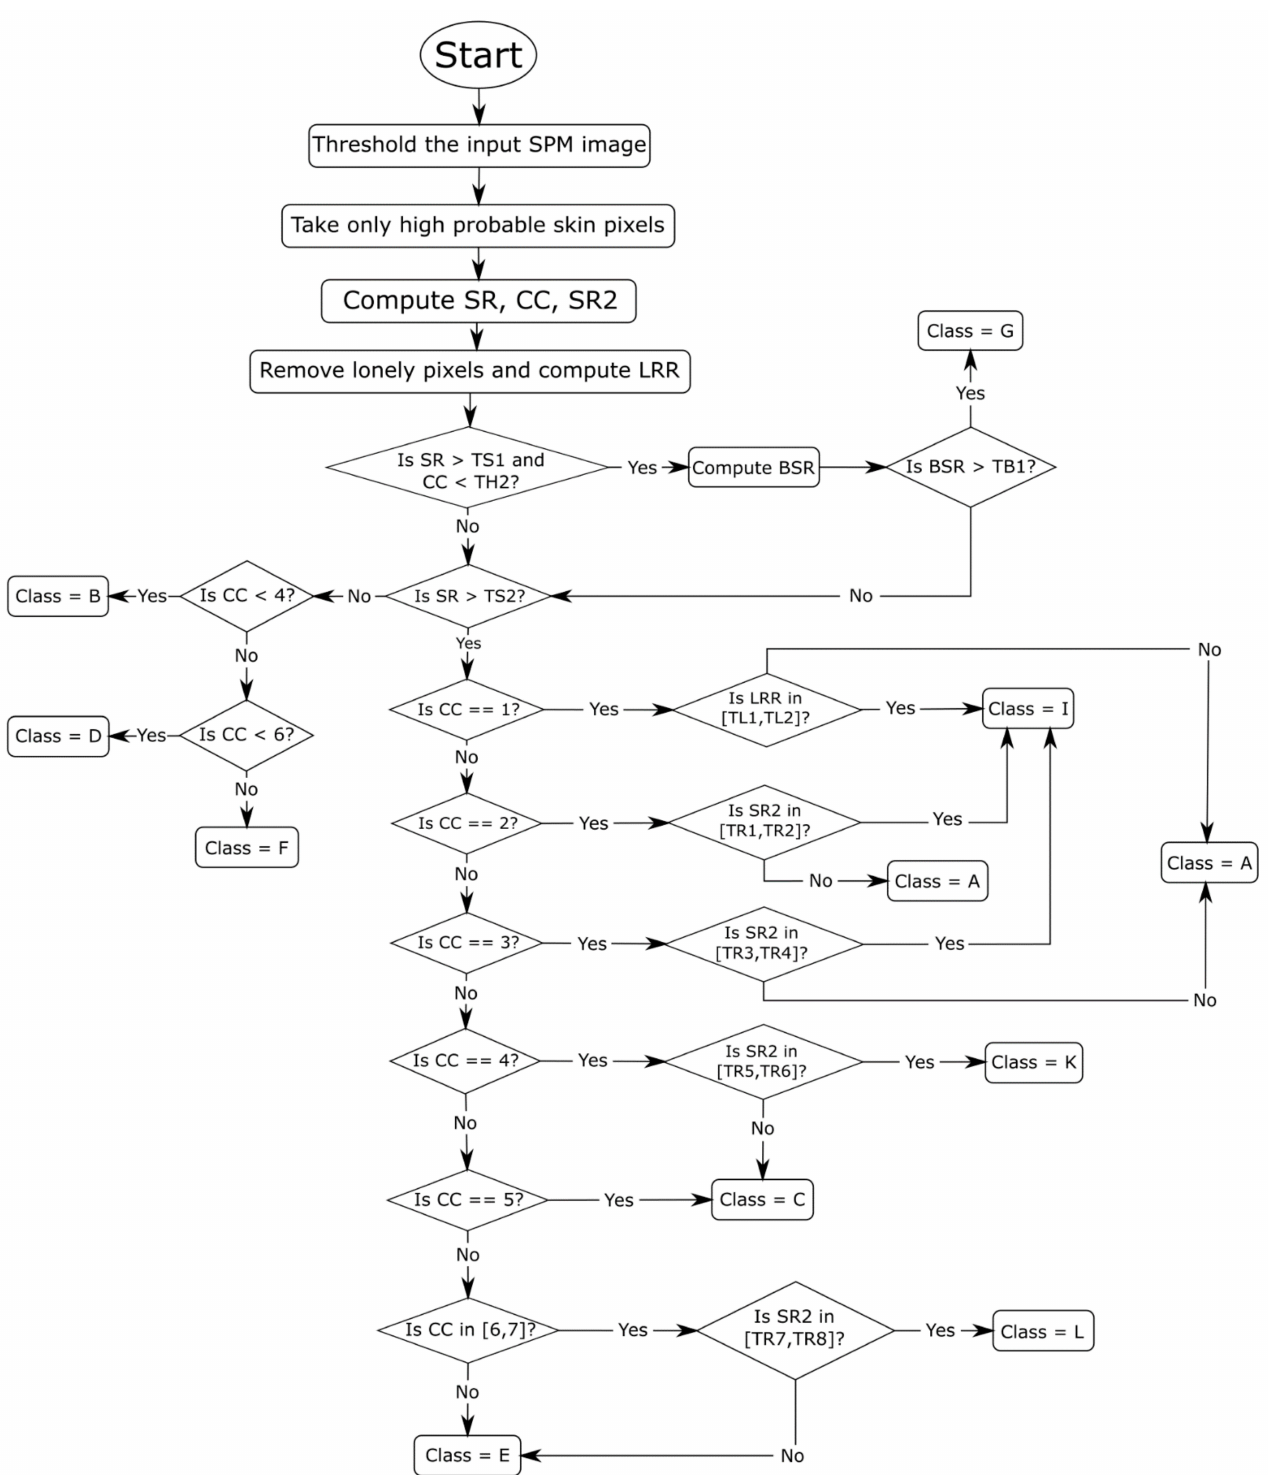
Figure 1. Flow chart of the image classification